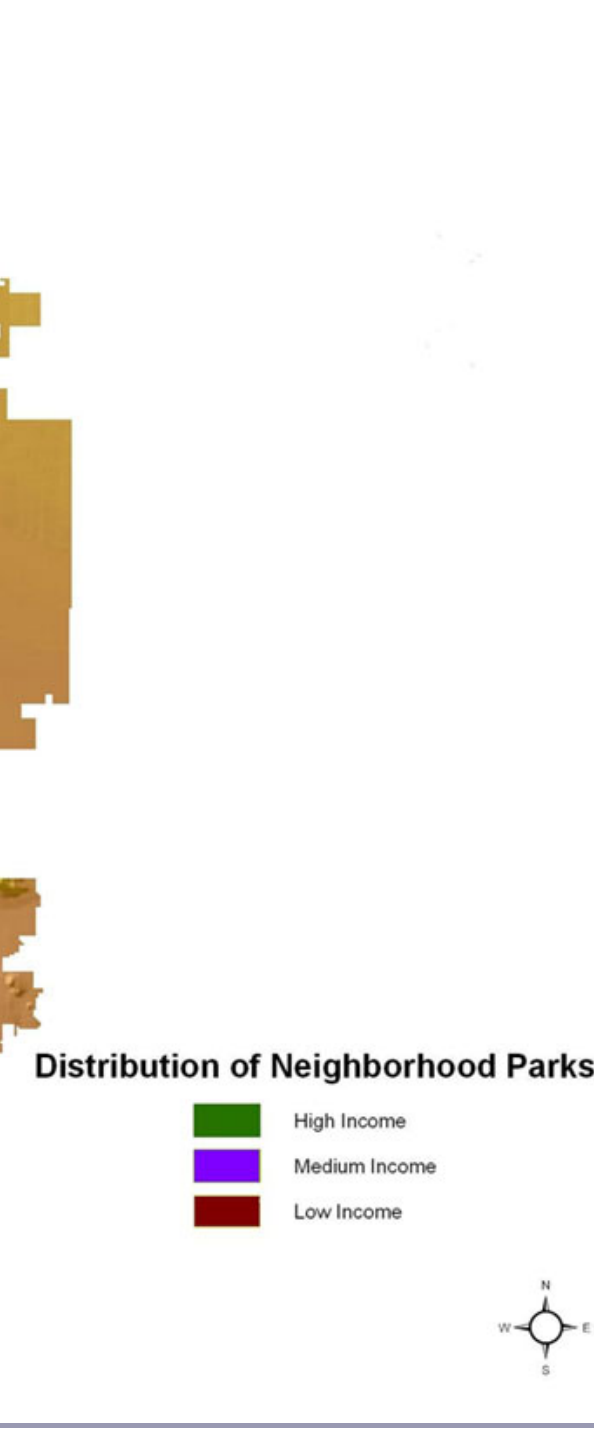
Fig. 3. The distribution of our focal parks within Phoenix. Dark green shows high socioeconomic status; light green shows low socioeconomic